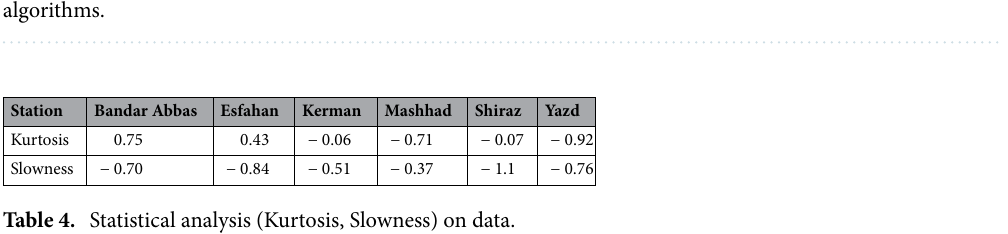
Table 3. The locally calibrated of the models coefficients for the selected stations using optimization algorithms.